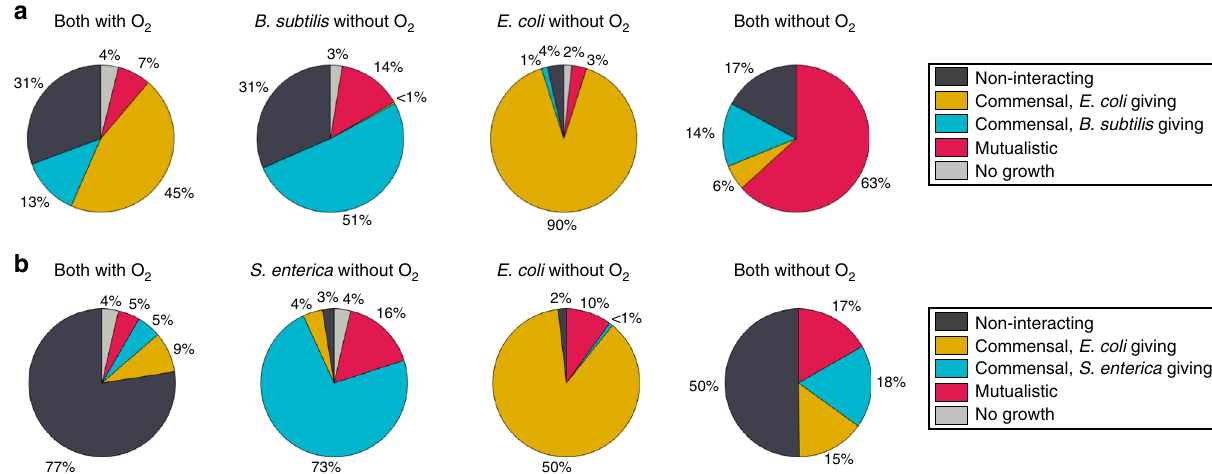
Fig. 6 Interaction type distributions from hybrid oxic – anoxic simulations for two organism pairs. a E. coli with B. subtilis . b E. coli with S. enterica . Both hybrid simulations demonstrate that regardless of organism, availability of oxygen is a strong determiner of the potential for bidirectional exchange. When oxygen is not provided to an organism in these simulations, it tends to provide metabolites to its partner, resulting in an abundance of commensal interactions. These scenarios may act as a “ stepping stone ” toward fully anoxic environments, in which mutualistic interactions become more